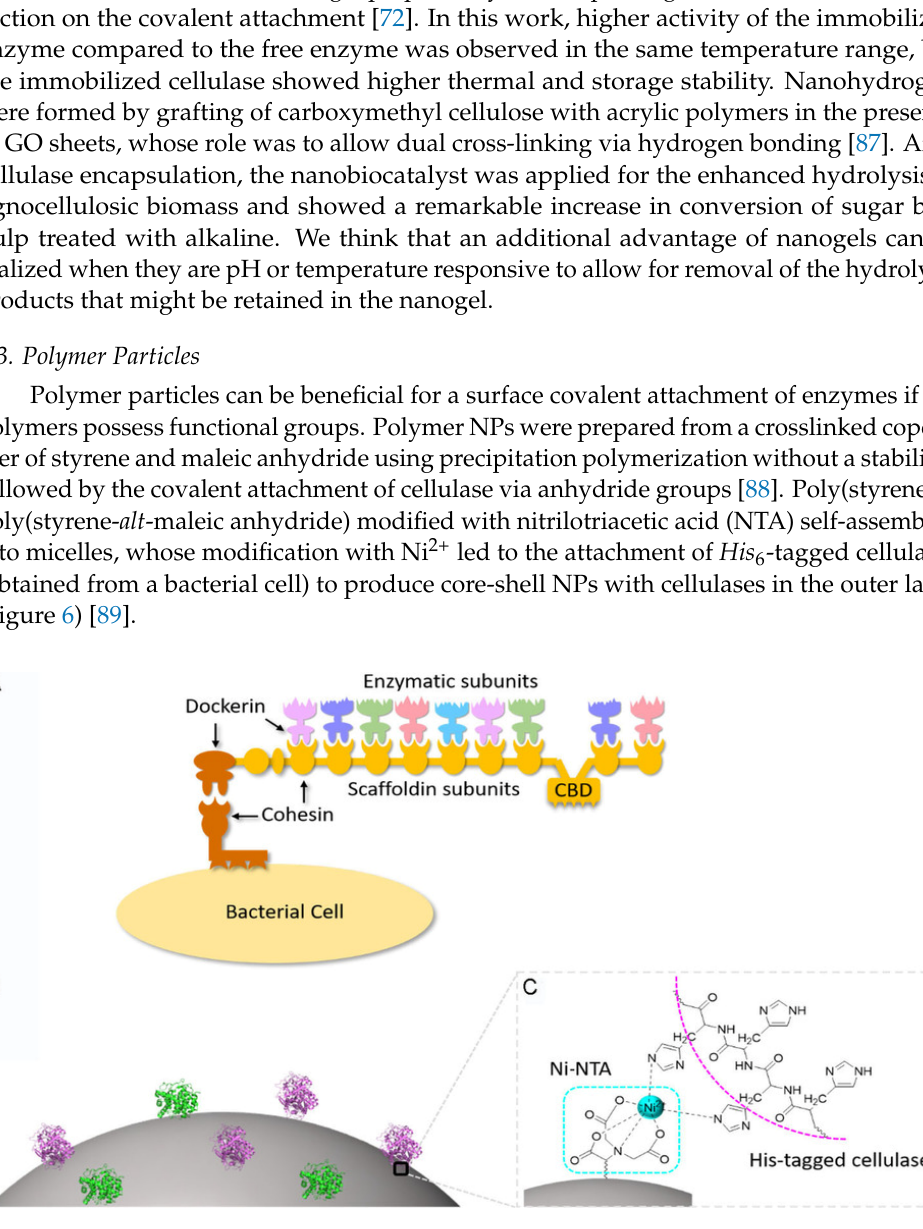
Figure 6. Schematic illustration of ( A ) the structural organization of the cellulosome of Clostridium thermocellum , ( B ) Ni-NTA-functionalized micelles for immobilizing cellulases, and (C) the interaction of Ni-NTA with His 6 -tagged cellulases. Reproduced with permission from [89], Wiley, 2019. Such hierarchical structure allowed for cellulase exposure to the reaction media and preservation of cellulase conformation due to a soft support. A chitosan-cellulase nano- hybrid has been prepared by self-assembly of chitosan in the presence of cellulase fol- lowed by immobilization on alginate beads [49].